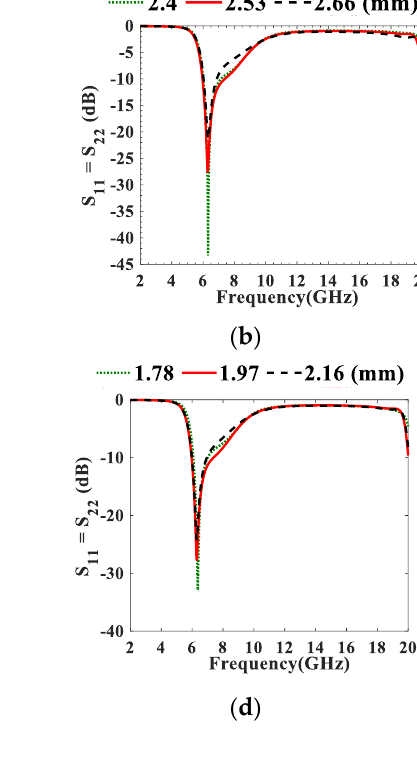
t , and ( c ) rvia . Figure 7. Parametric studies of the proposed NTL IBPF at (3.7 – 4.2 GHz) on (a) S , (b) L t , and (c) rvia